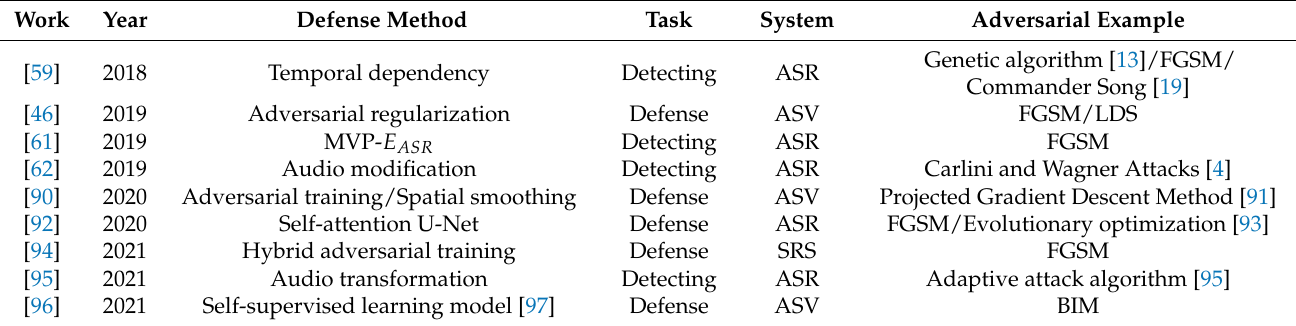
Table 2. The taxonomy of defense in speaker and speech recognition. ‘Task’ indices whether the defense method is completely defense or detection. An adversarial example is the generating method of the attack